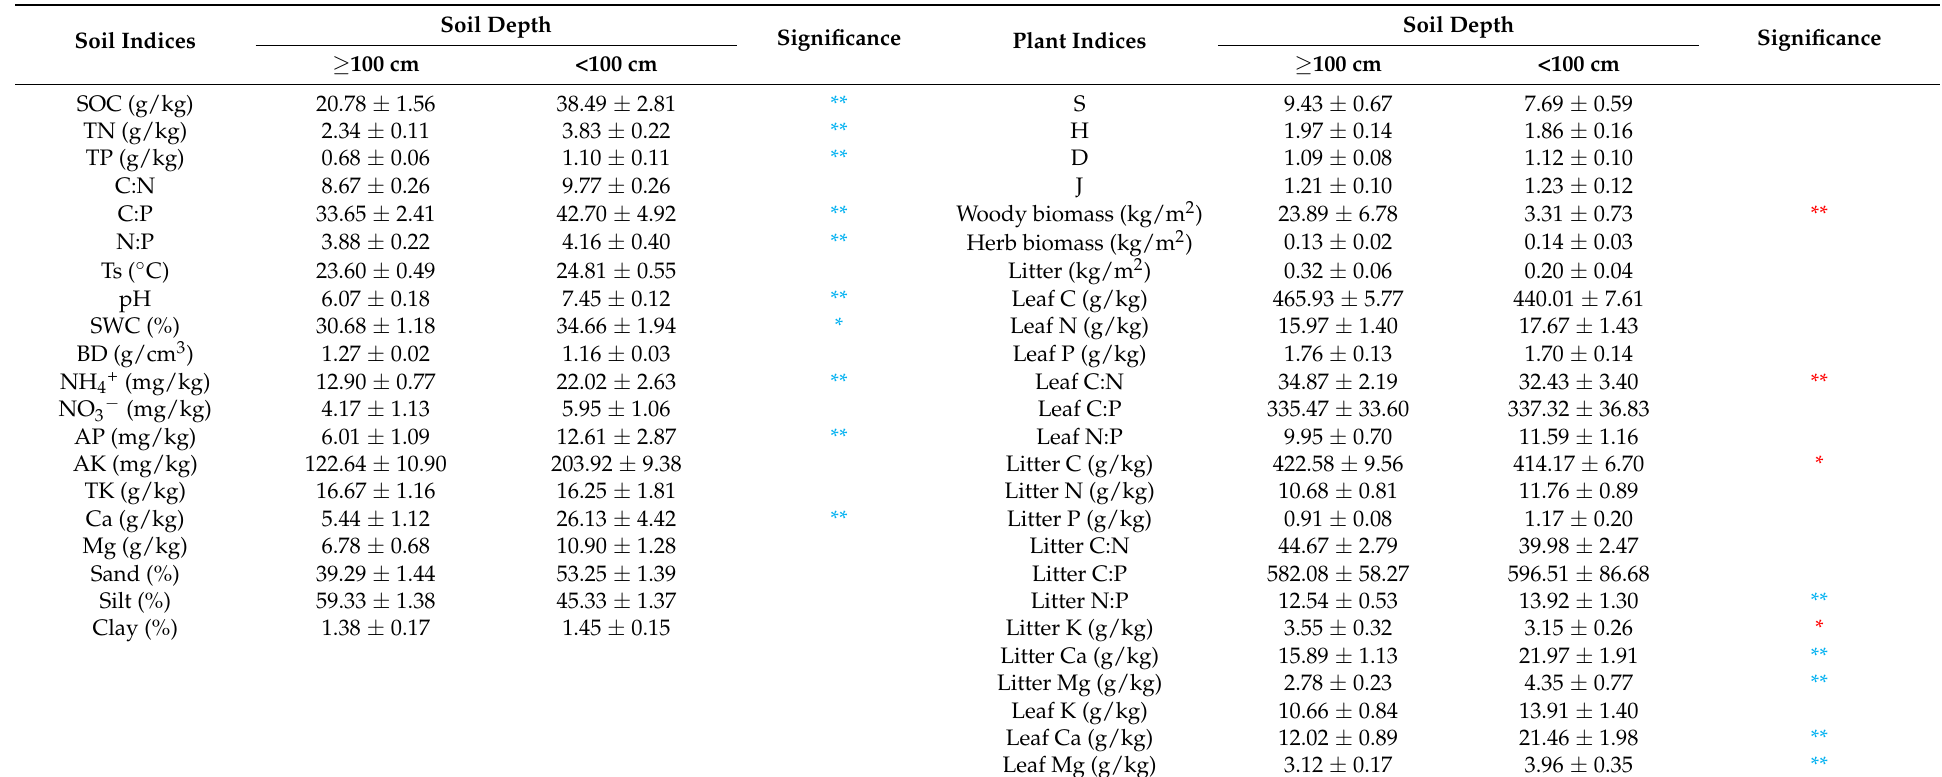
Table 2. Characteristics of plant–soil physical and chemical properties of the two soil